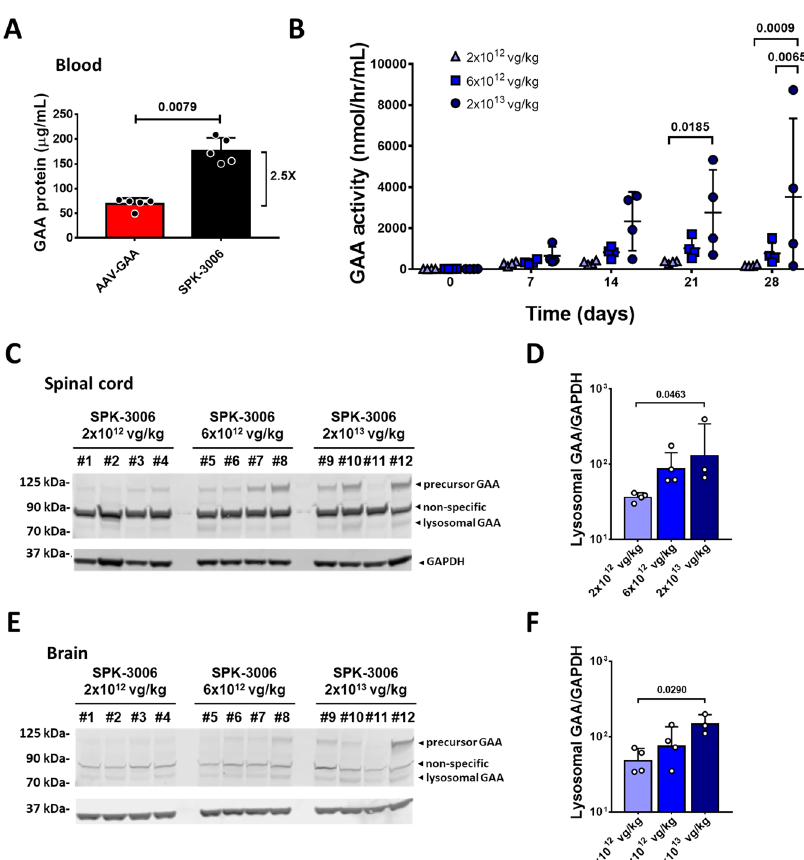
Fig. 9 SPK-3006 drives vector dose-dependent expression of GAA in liver and tissue uptake in non-human primates. A Circulating GAA antigen levels 4 weeks of post-injection of C57BL/6 mice with AAV-GAA or SPK-3006 at 2 × 10 12 vg/kg ( n = 5 per group). B GAA activity in plasma of non-human primates treated with SPK-3006 ( n = 4 per group). C , E Western blot analysis of GAA antigen levels in spinal cord ( C ) and brain ( E ). D , F Quanti fi cation of lysosomal GAA antigen in spinal cord ( D ) and brain ( F ) (2 × 10 12 and 6 × 10 12 vg/kg, n = 4 per group; 2 × 10 13 , n = 3). Data shown as average ± SD. Statistical analysis: A Two-sided Mann – Whitney t -test; B Two-way ANOVA with Tukey post-hoc test; D , F One-way